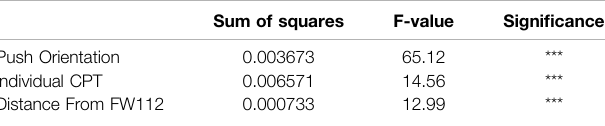
TABLE 4 | Tukey Honest Signi fi cance Difference test of change in hydraulic head (m) for location of CPT boreholes relative to FW112.